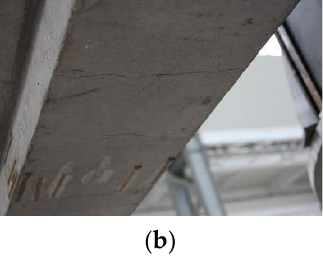
Figure 9. Acceleration response at the mid-span with multidirectional excitation. ( a ) Beam 1; ( b ) Beam 2; ( c ) 1/4-span of Beam 3.